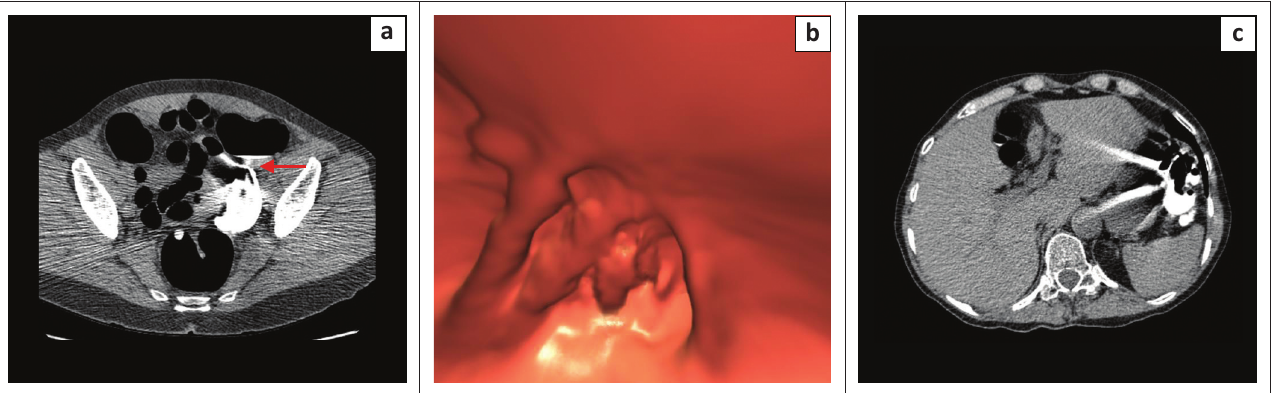
FIGURE 11: (a) Dense ‘waterfall sign’ in the rectosigmoid region, caused by flowing fluid (red arrow) during the scan process; (b) 3D endoluminal view showing artefact from fluid movement; (c) Dense waterfall sign in descending colon showing classical streak artefact because of fluid movement.